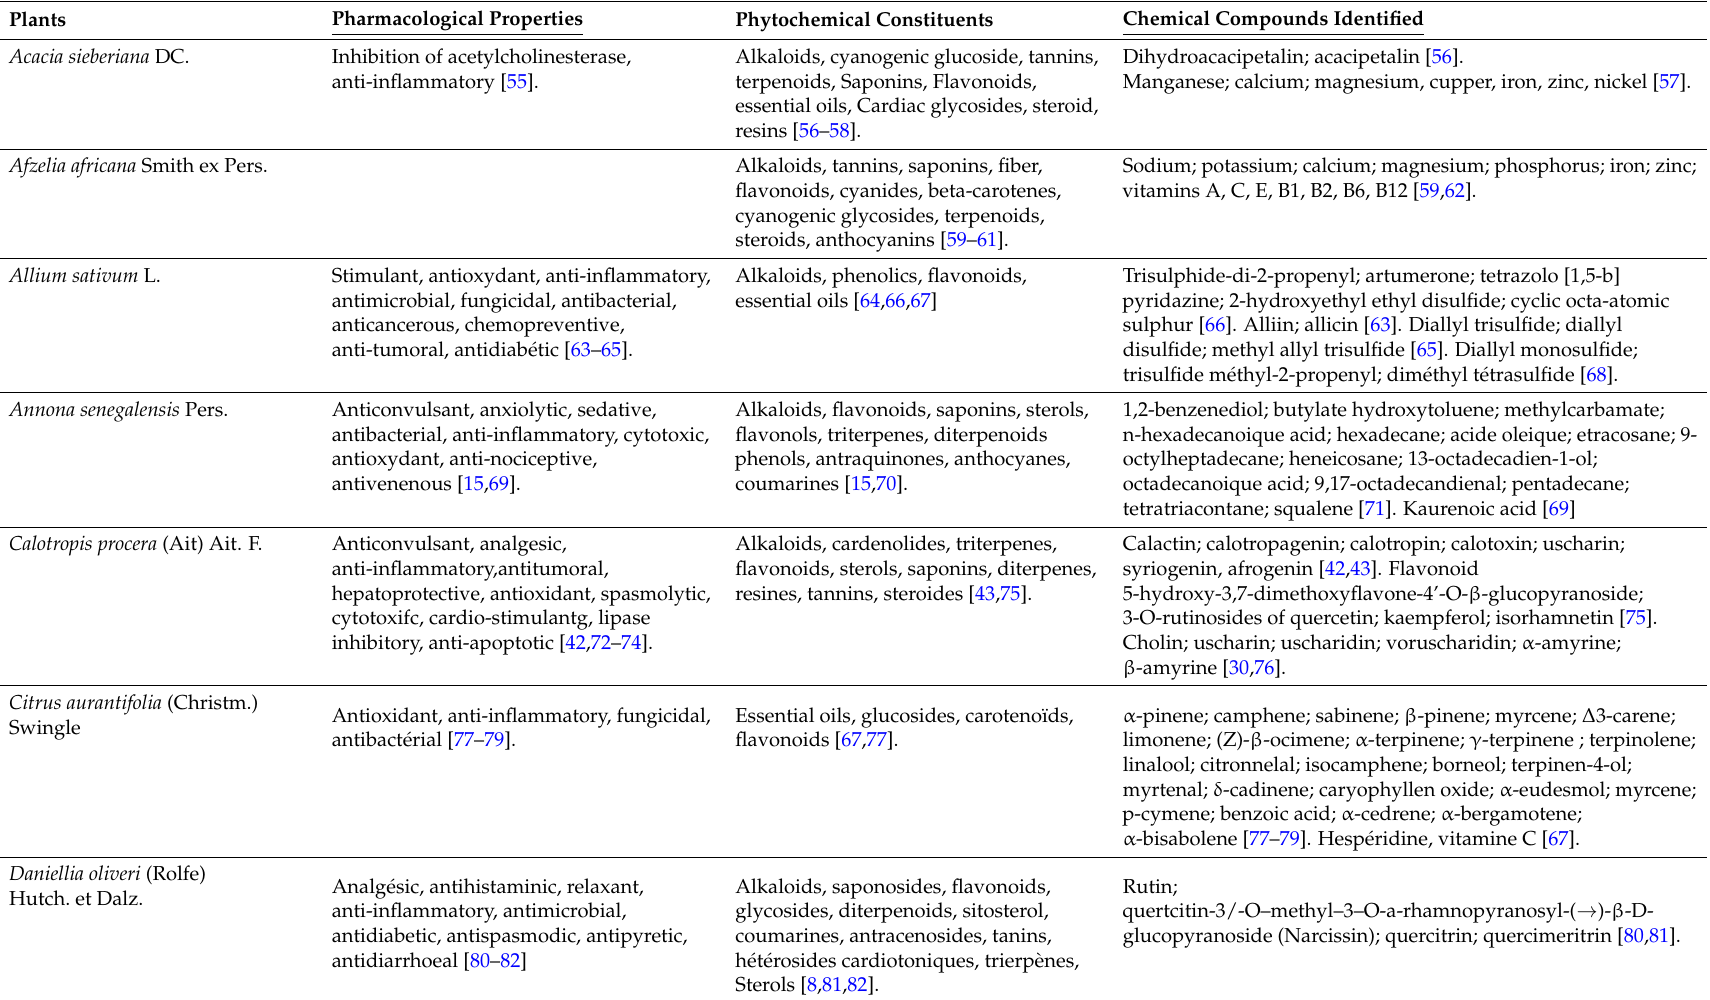
Table 4. Phytochemical constituents and pharmacological properties of main plants